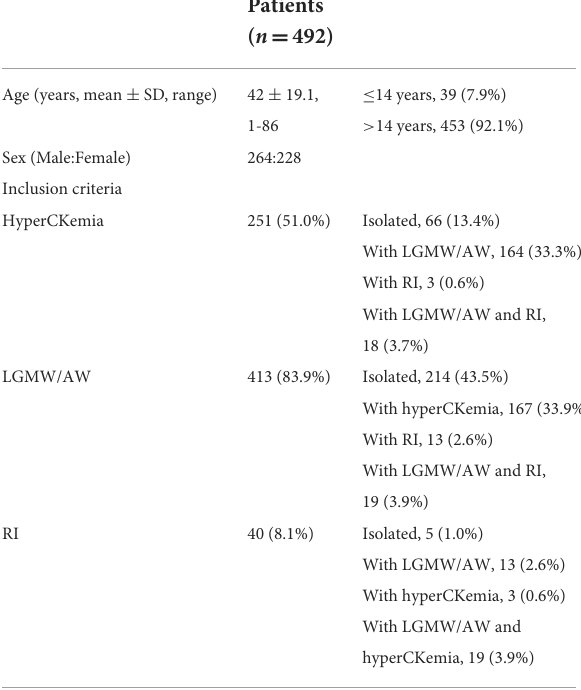
TABLE 1 Summary of the demographic and clinical characteristics of the